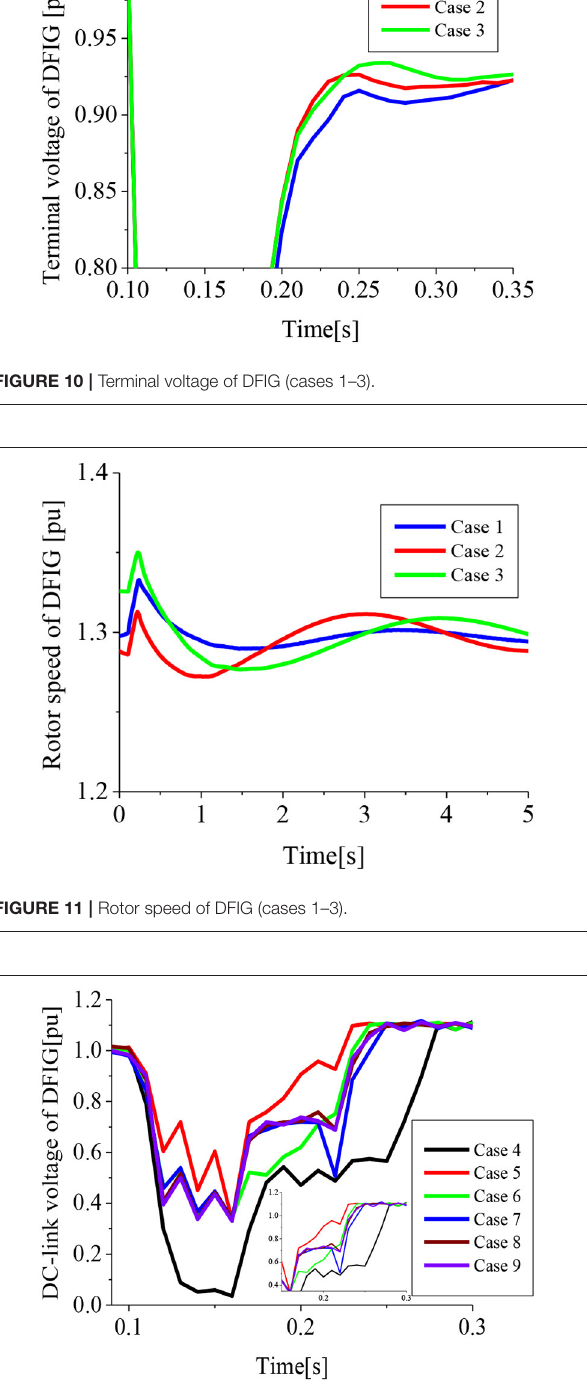
FIGURE 12 | DC-link voltage of DFIG (cases 4–9).